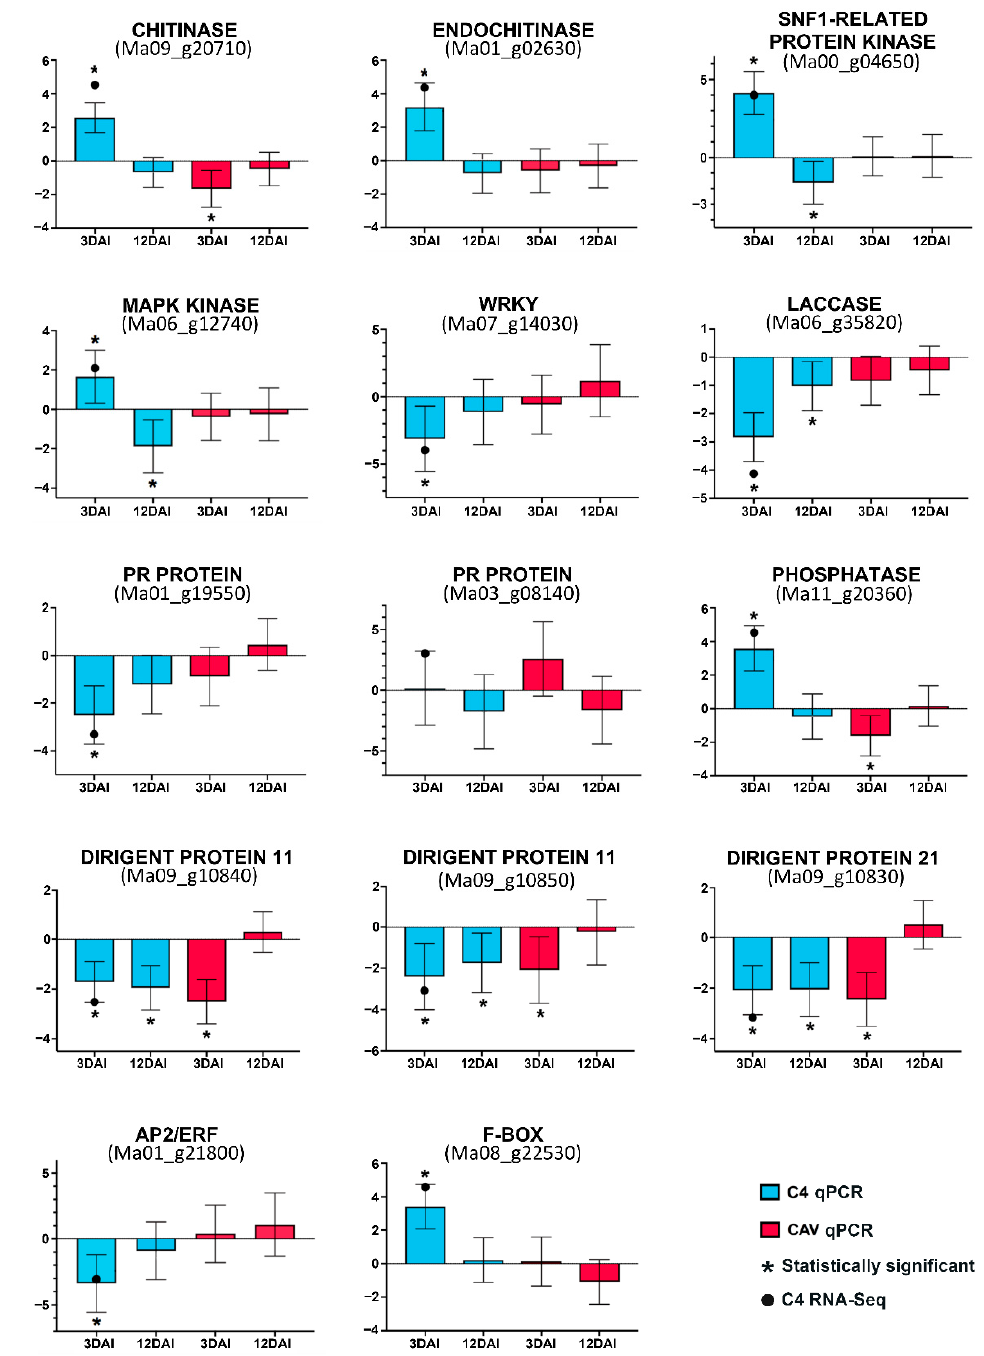
Figure 6. RT-qPCR validation of differential expression profiles based on RNA-seq for selected genes in Musa acuminata var. Calcutta 4 in inoculated leaf tissues versus non-inoculated controls and comparison of expression in Musa acuminata Cavendish Grande Naine. Standard error values (bars) were based upon analysis of three biological replicates per genotype and time point and three technical replicates per amplification.